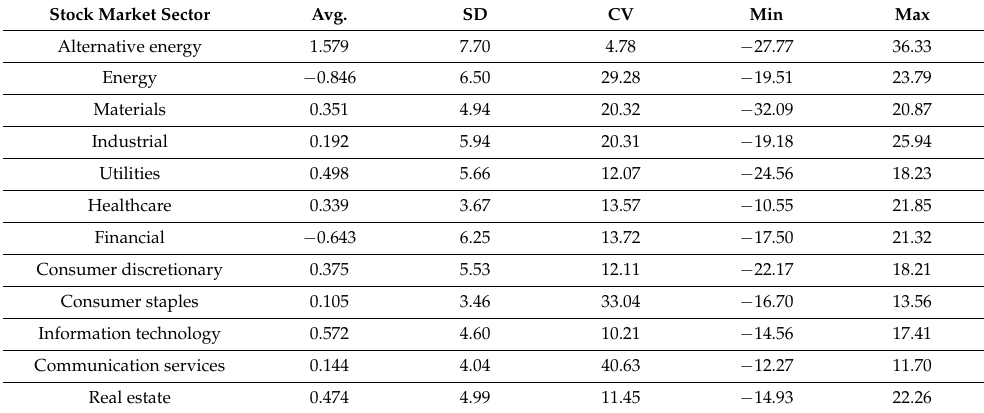
Table 3. Descriptive statistics for average weekly rates of return of alternative energy and main stock market sectors: based on the performance of the top five companies in January–September 2020. Stock Market Sector